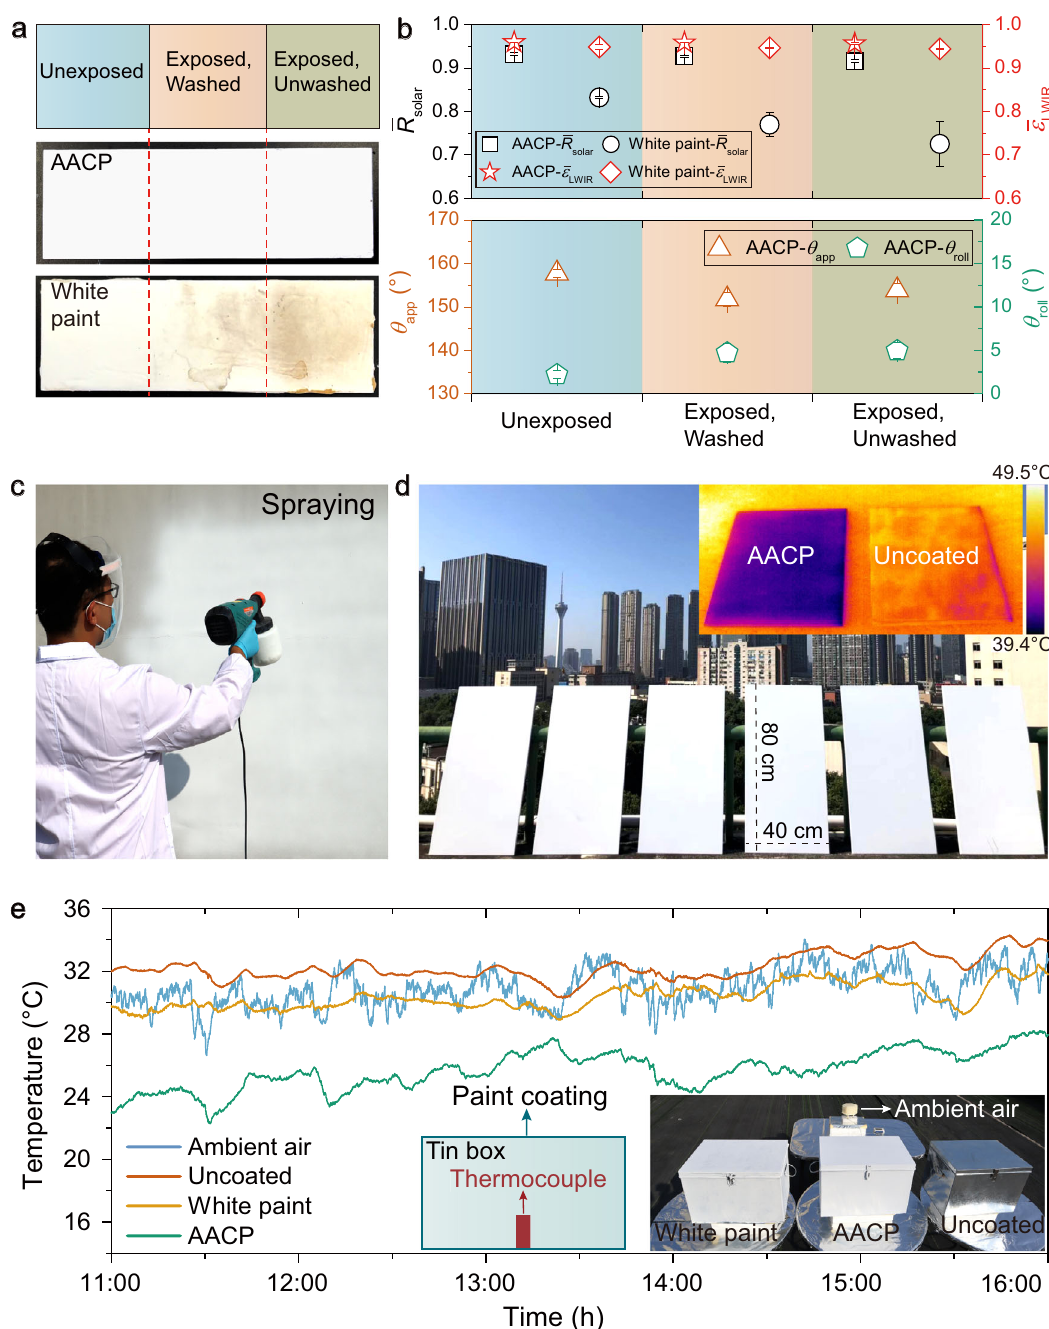
Fig. 4 | The real-world outdoor durability test, demonstration of versatility, scalability and proof-of-concept. a Photographs and b the optical and wetting propertiesoftheAACPandwhitepaintcoatingafter6monthsofoutdoorexposure (Chengdu, 30°40'36''N, 104°6'28''E, from April 25th to November 10th 2021). We studied the optical and wetting properties of the coatings against environmental aging by dividing the coating slide (5×15cm) into three regions: unexposed/ (exposed, washed)/(exposed, unwashed). c Demonstration of spray coating and